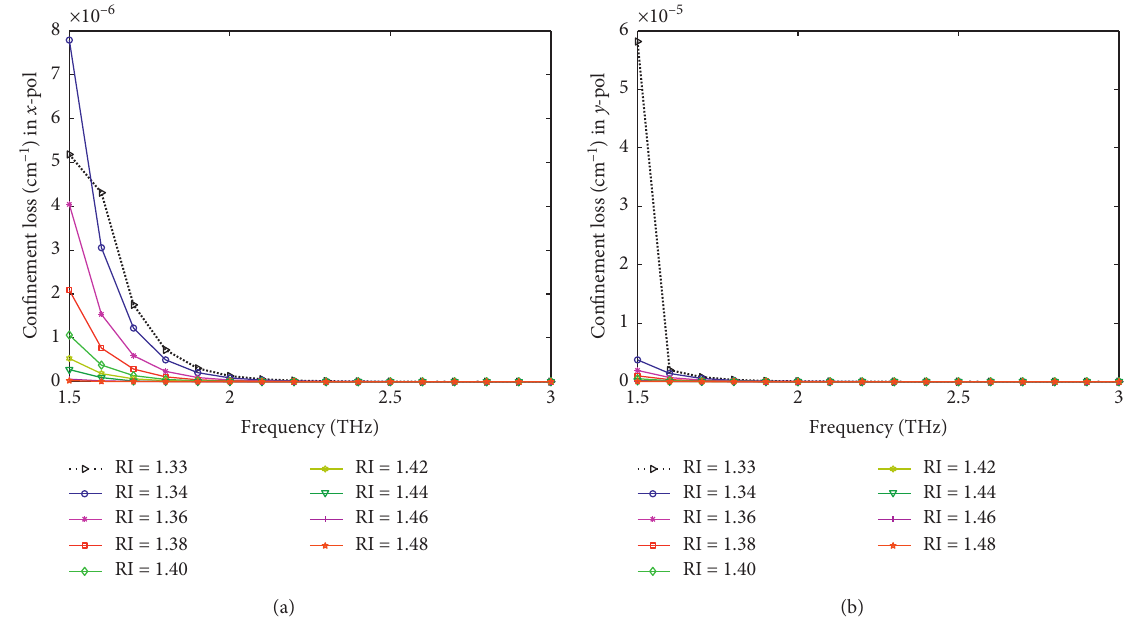
Figure 19: Comparison of the CL of the proposed model in the THz band for different analytes. (a) x -PoM and (b) y -PoM.